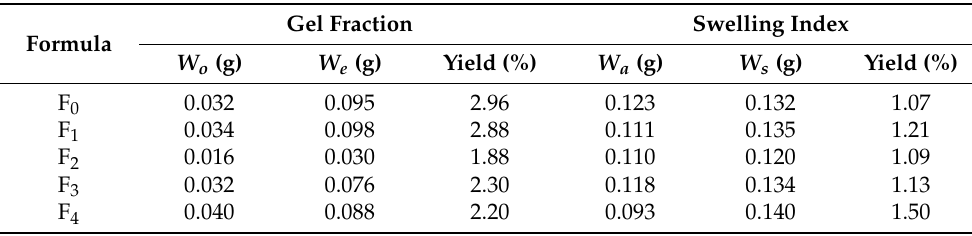
Table 8. Gel fraction and swelling index test polyvinyl alcohol/corn starch/patchouli oil/hydrogel films loaded with silver